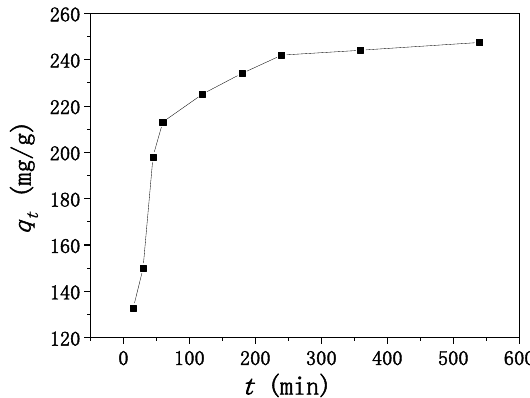
Figure 5. Variation curve of uranium (VI) adsorption capacity of NiCo 2 O 4 /MWCNTs with pH. tem- perature, 25 °C; C 0 , 150 mg L − 1 ; pH, 2.0–10.0; the mass of NiCo 2 O 4 /MWCNTs, 0.01 g.